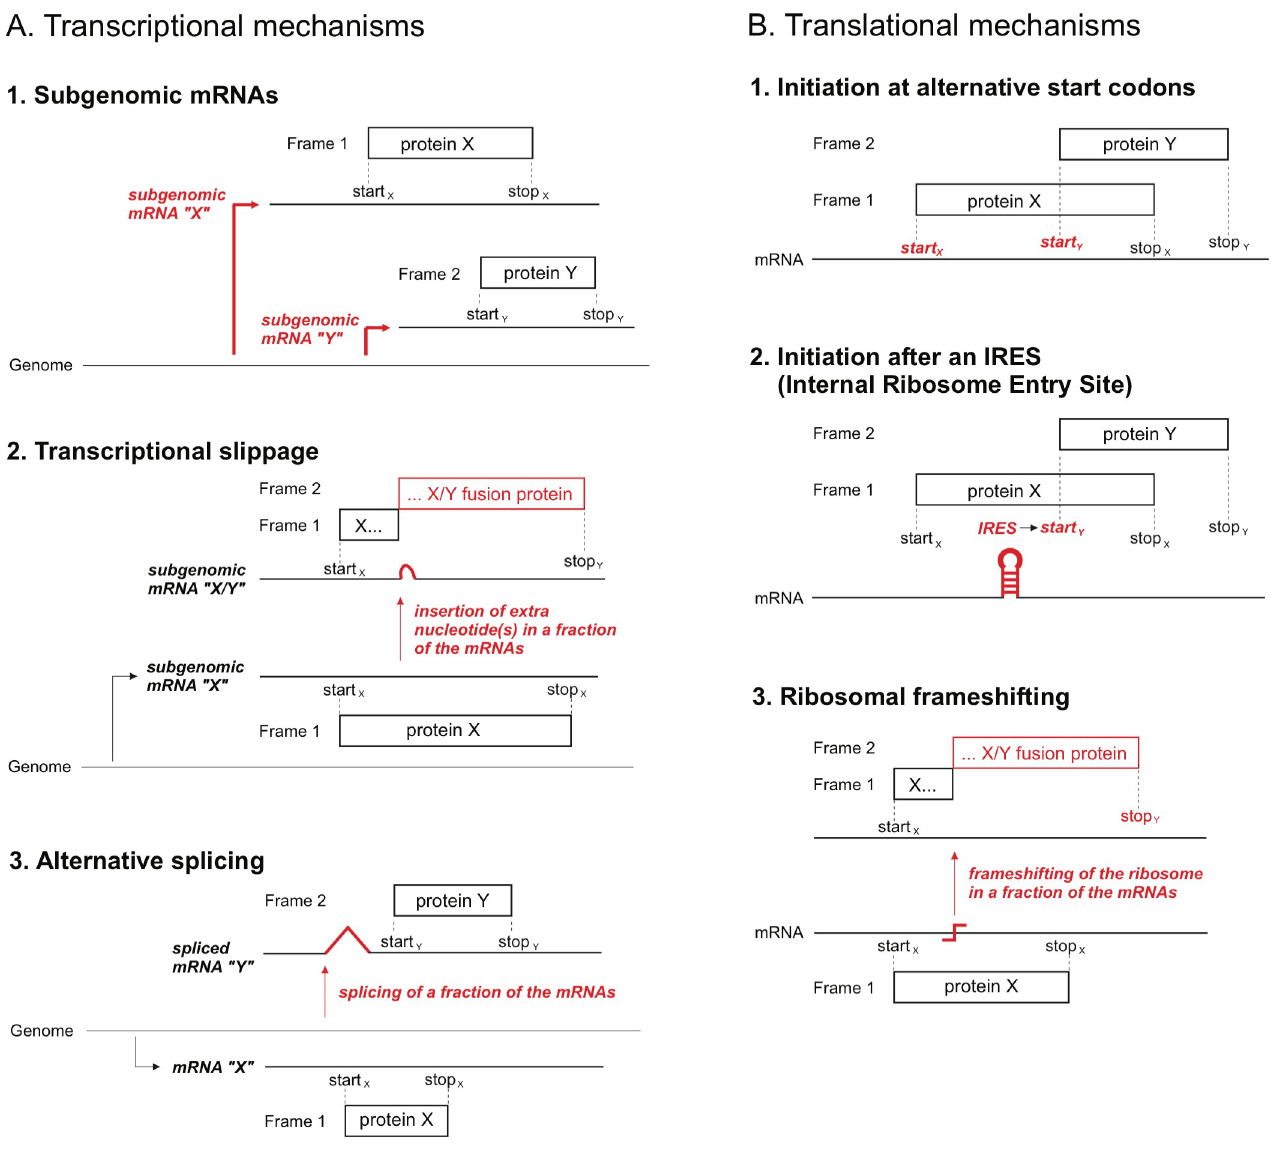
Fig 2. Main mechanisms used to express the proteins encoded by overlapping genes.